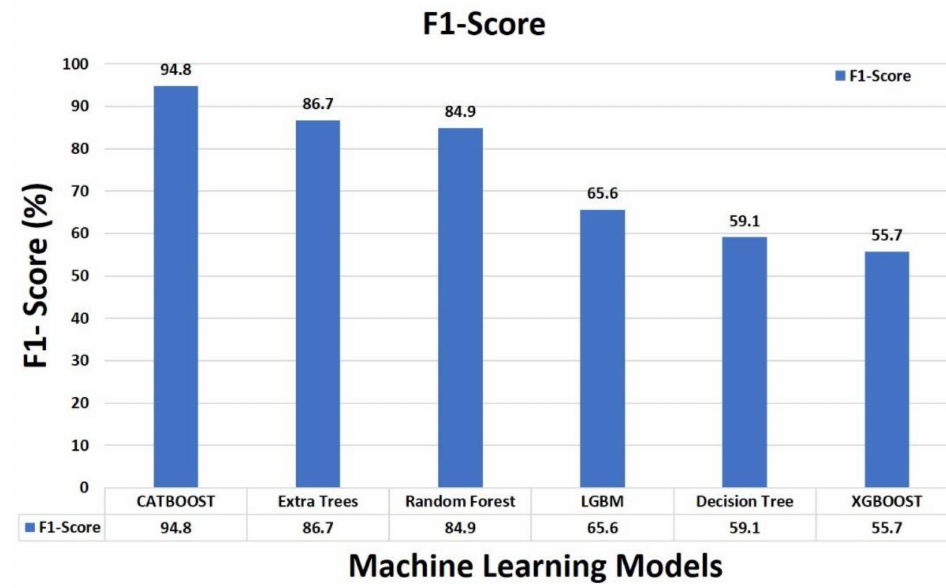
Figure 6. Baseline model F1 score comparison.